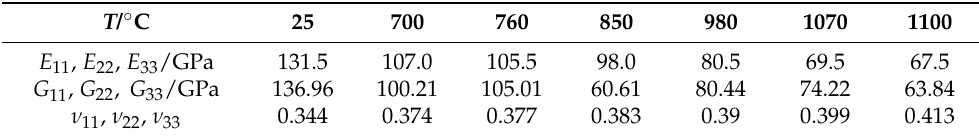
Table 1. DD6 material elastic properties adapted from reference [24]. T / ◦